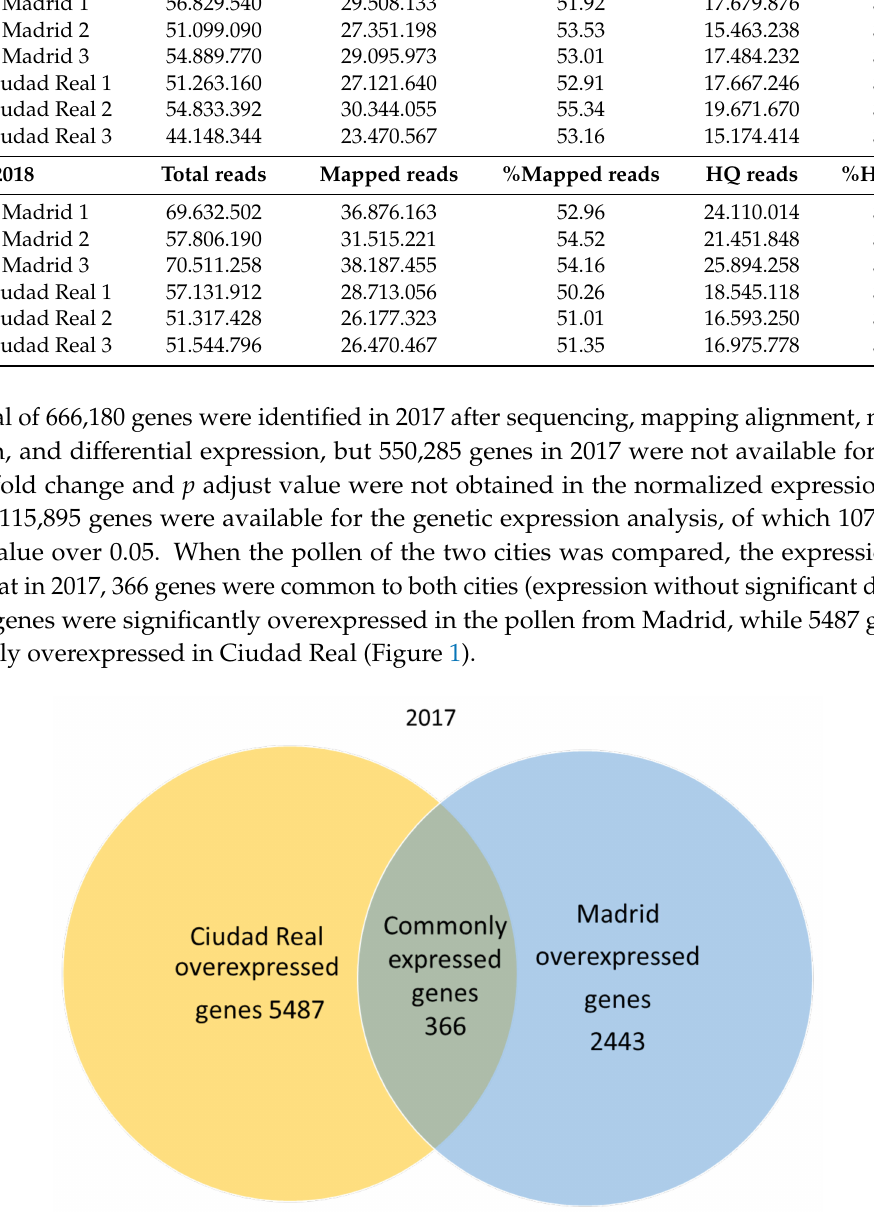
Figure 1. Venn diagram of overexpressed and common genes in the samples of pollen from Madrid and Ciudad Real in 2017 with a p adjust value <